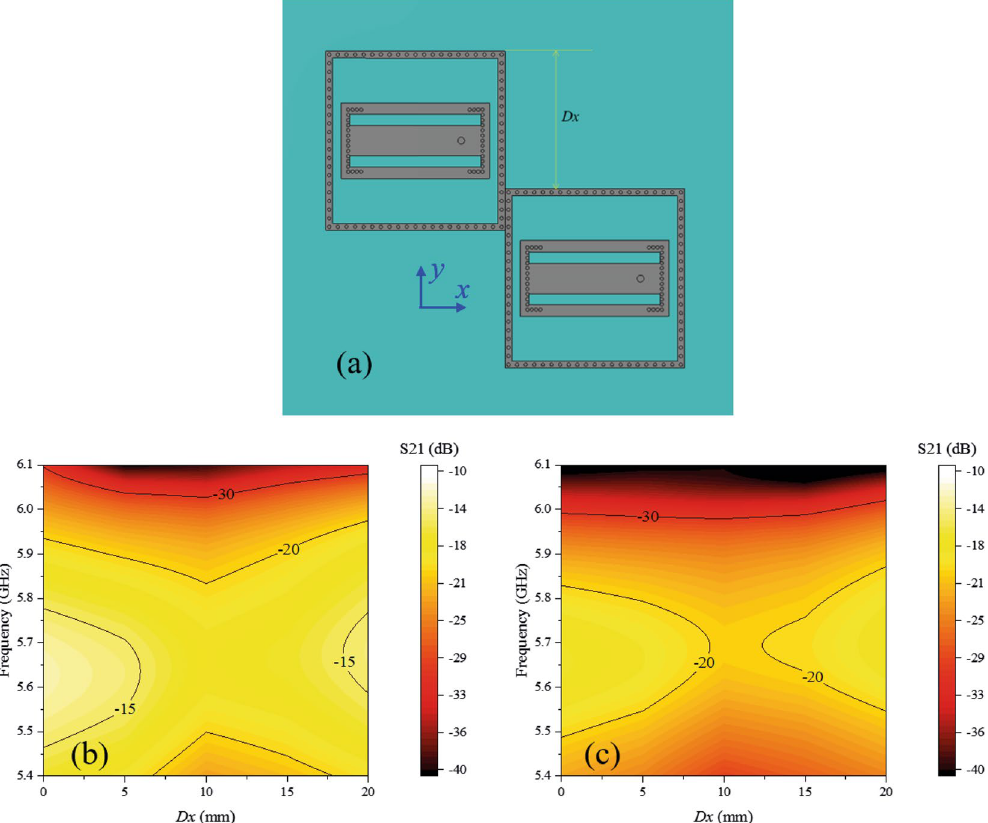
Figure 10. Relations between the distance Dx and element coupling. ( a ) Schematic of the array with two end- to-end elements. ( b ) S21 versus different distance Dx when the antennas have no decoupling cavities. ( c ) S21 versus different distance Dx when the antennas have decoupling cavities. In the operational frequency band, the mutual coupling decreases when the distance Dx increases from 0 to 10 mm and then increases. S21 map in ( c ) is approximately 3 dB weaker than that in ( b ), which means the decoupling cavity can weaken the mutual coupling.